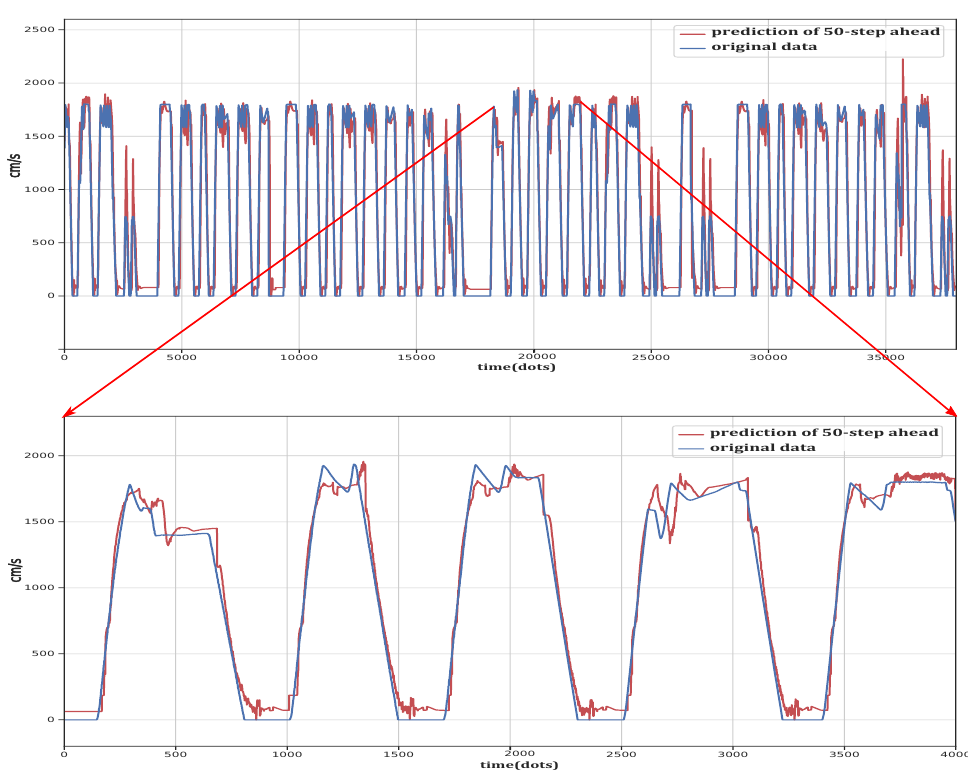
Figure 10. Comparison of the original data and the output of 50-step-ahead